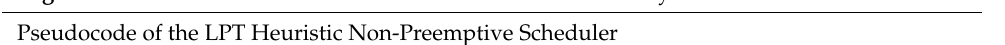
Algorithm 1. Pseudocode for LPT executed at the OLT for each cycle i